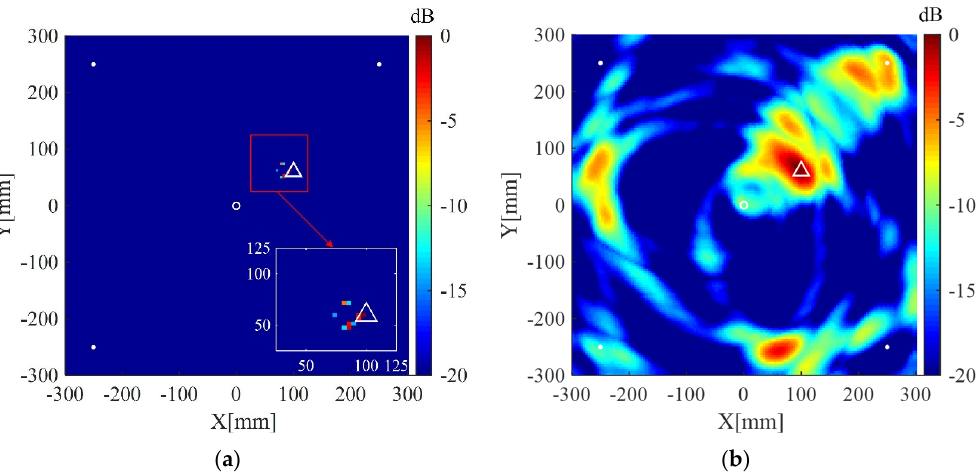
Figure 10. ( a ) Imaging result of the weighted structured sparse reconstruction ‐ based Lamb wave imaging method using data from four receivers (the location error is 3 mm); ( b ) Imaging result of the delay ‐ and ‐ sum imaging method using data from four receivers (the location error is 3 mm). White dots denote locations of PZT receivers, the white circle denotes the location of excitation source, and the white triangle denotes the location of the